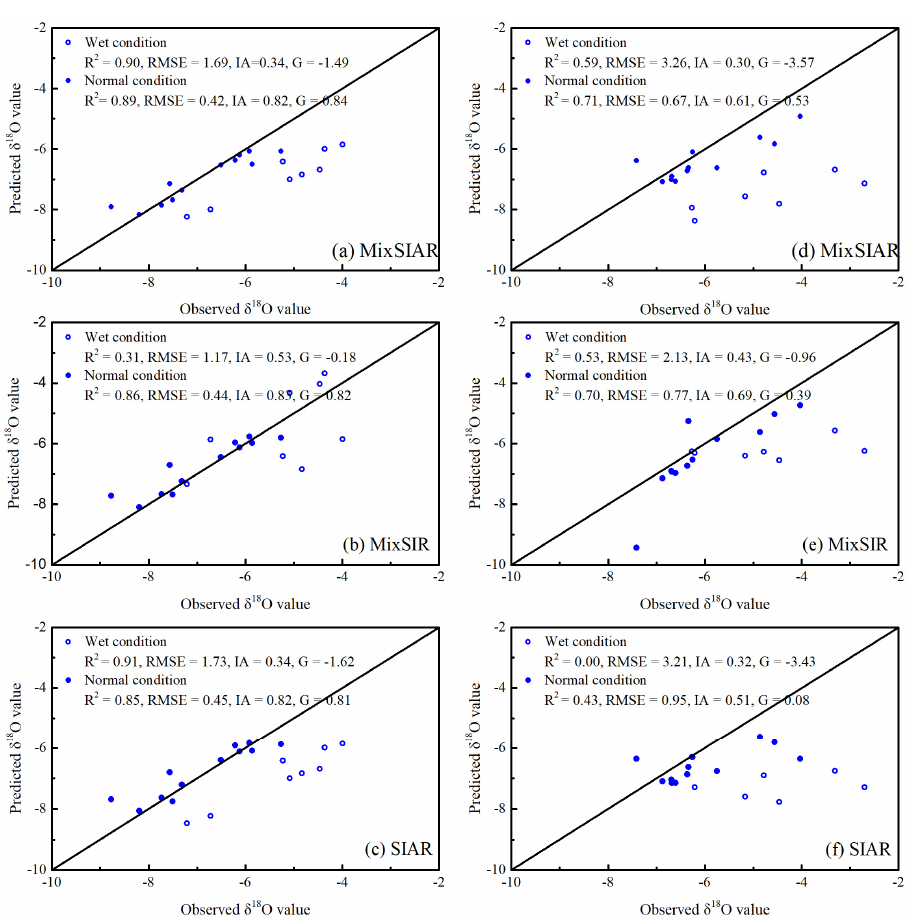
Figure 7. Comparisons between predicted and observed value of δ 18 O in 2017–2018 ( a – c ) and 2018–2019 ( d – f ) wheat seasons. The data originated from our previous study at the same site [9].